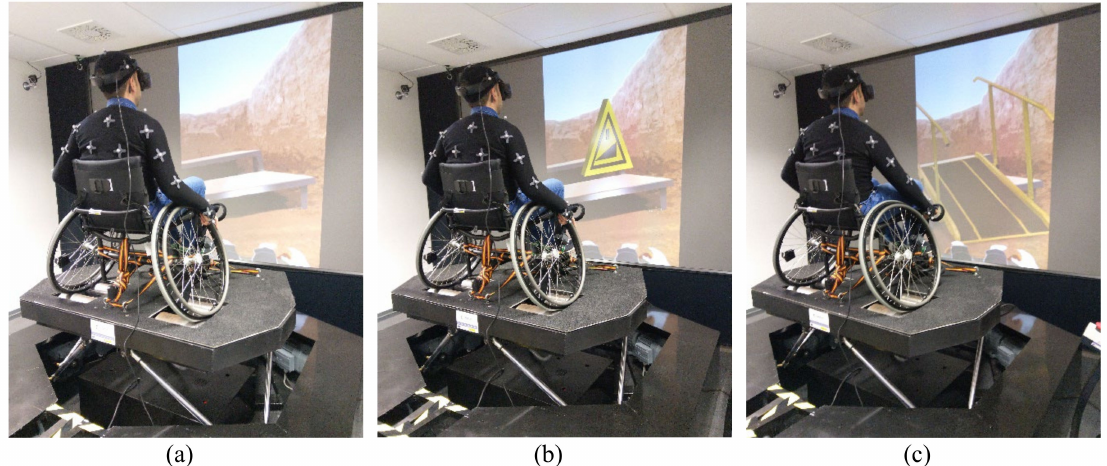
Figure 10. Example of the use of ramps: ( a ) the user approaches some stairs; ( b ) an icon warns the user and reminds him a ramp is available; ( c ) the ramp arises after pressing a